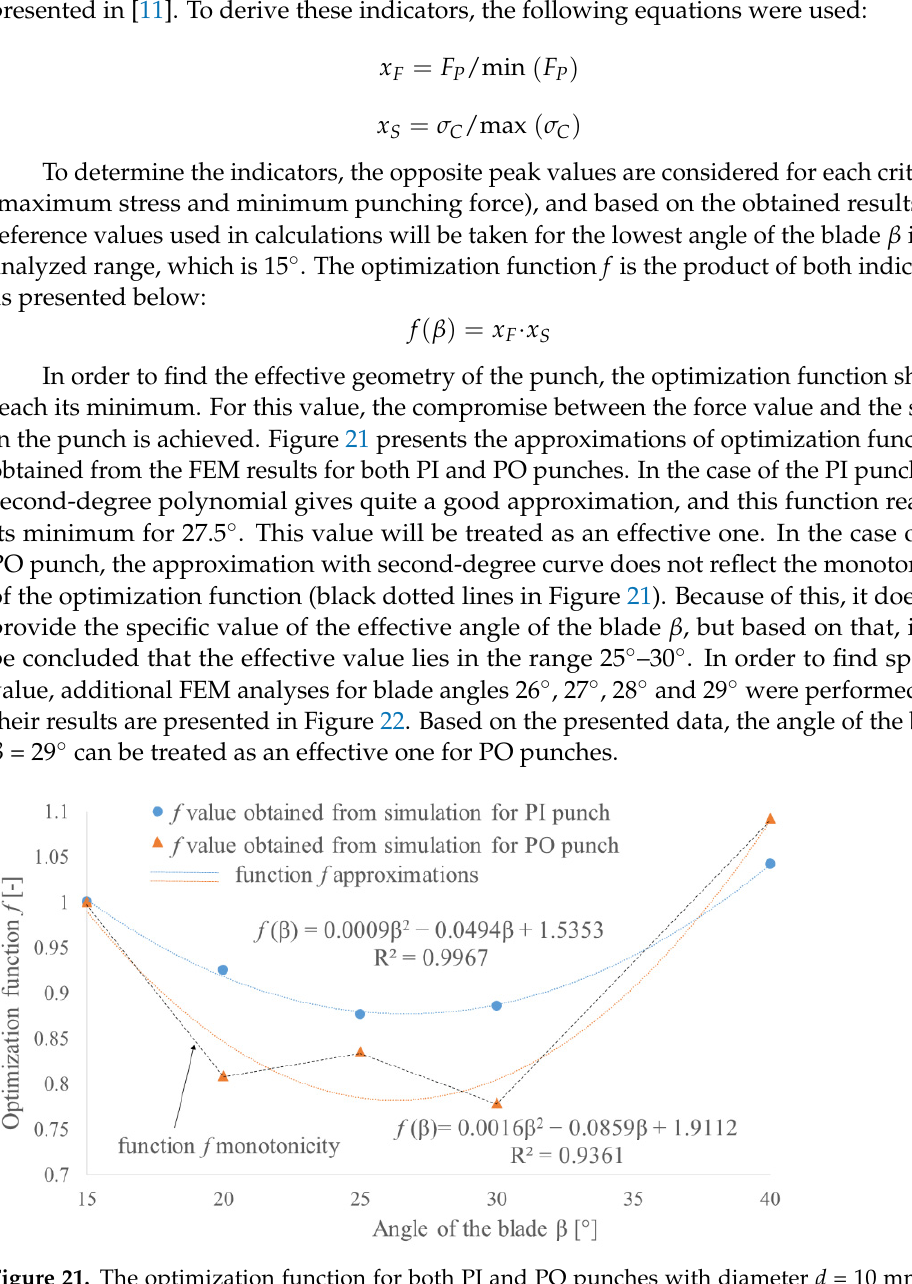
Figure 21. The optimization function for both PI and PO punches with diameter d = 10 mm and height of the blade H = 2.65 mm for belt TFL10S.